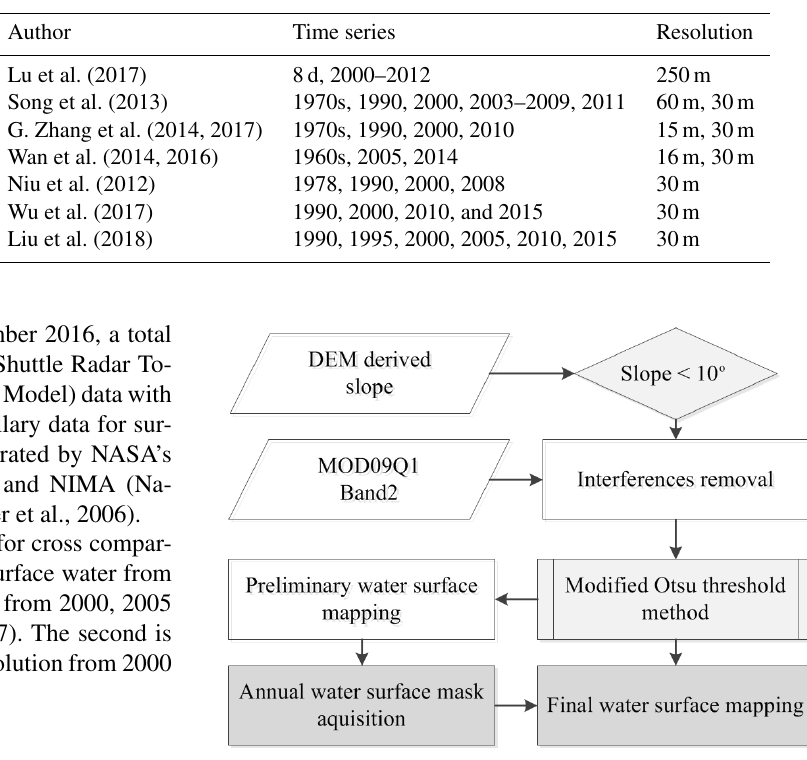
Figure 1. Flowchart of the water surface extraction method. See Lu et al.